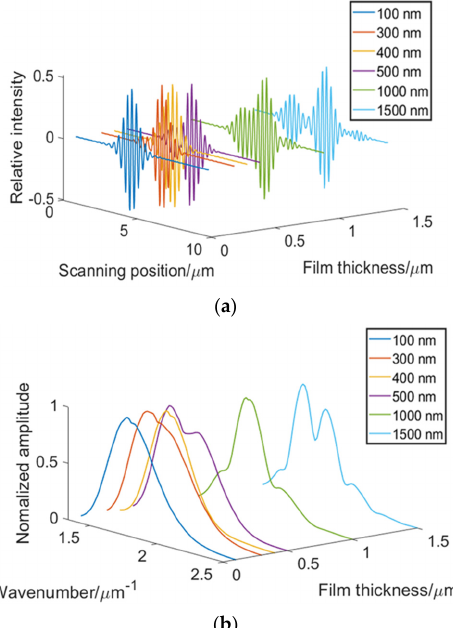
Figure 3. ( a ) Vertical scanning interferometer (VSI) signals. ( b ) Fourier-transform-normalized amplitudes of SiO 2 films with different thicknesses.